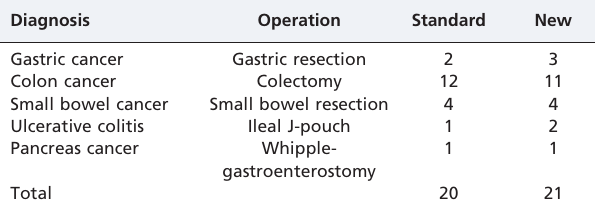
Table 2 - Preoperative diagnosis and operations. Diagnosis